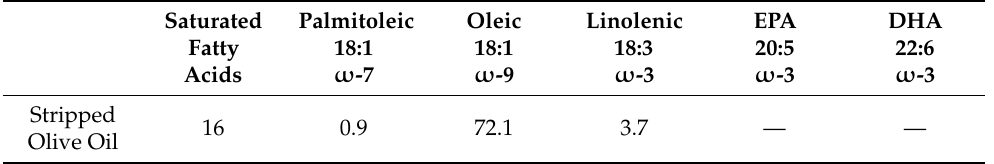
Table 1. Composition (given as percentage in weight) of the main fatty acids of the olive oil employed in this work (EPA: eicosapentaenoic acid, DHA: docosahexaenoic